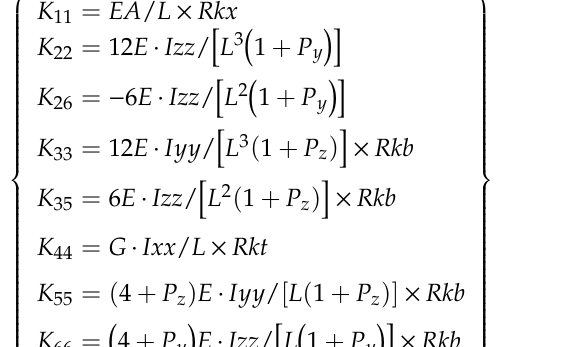
Figure 3. Parameters of the pulley and rope grooves.